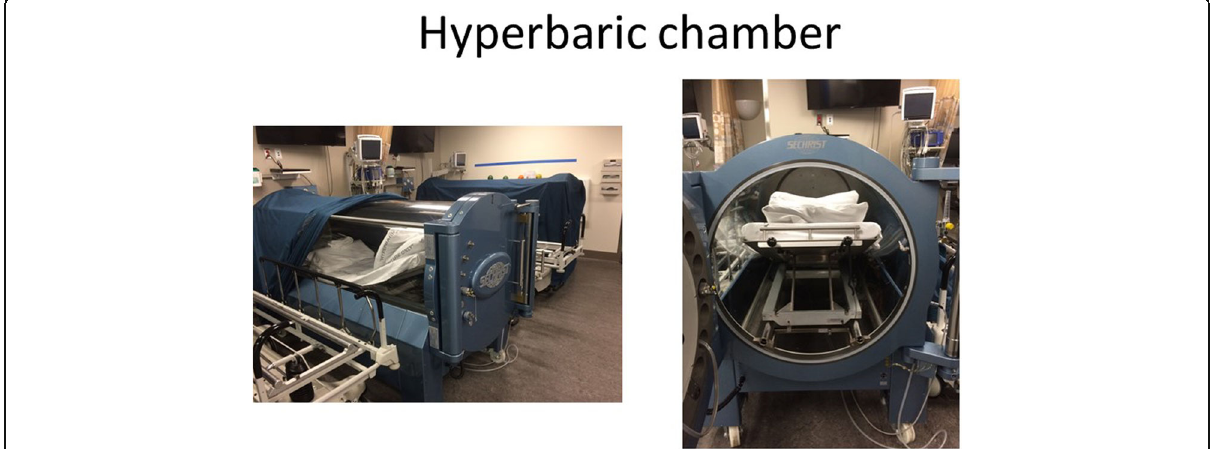
Fig. 1 Hyperbaric chamber. Image of the used hyperbaric chamber. Model 3300, company ’ s name: Sechrist, Anaheim, California, USA, year of manufacture: